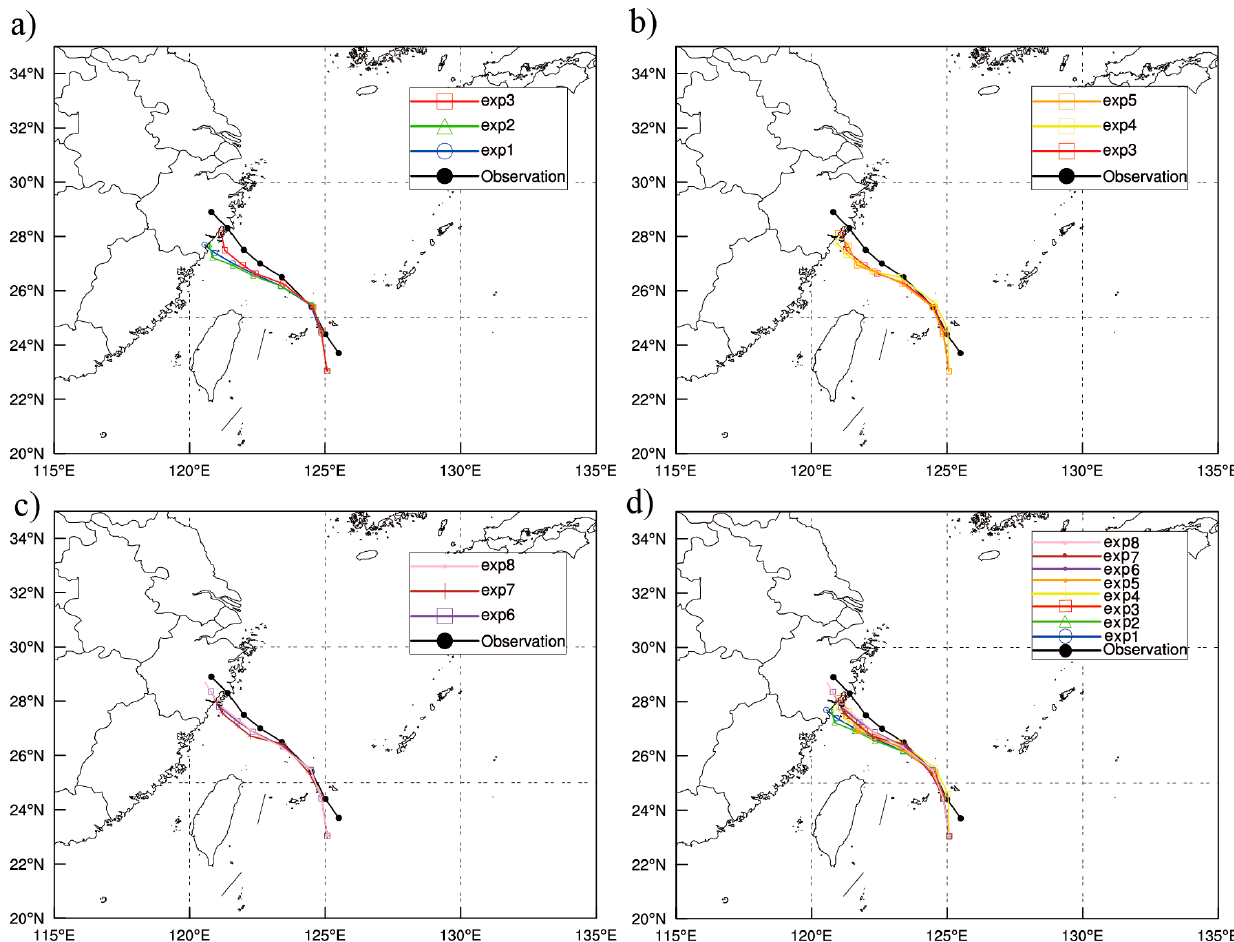
Figure 3. The track for: ( a ) exp1, exp2, and exp3, ( b ) exp3, exp4, and exp5, ( c ) exp6, exp7, and exp8, ( d ) all the experiments for the 42 h forecasts from 0600 UTC 8 August to 0000 UTC 10 August 2019.